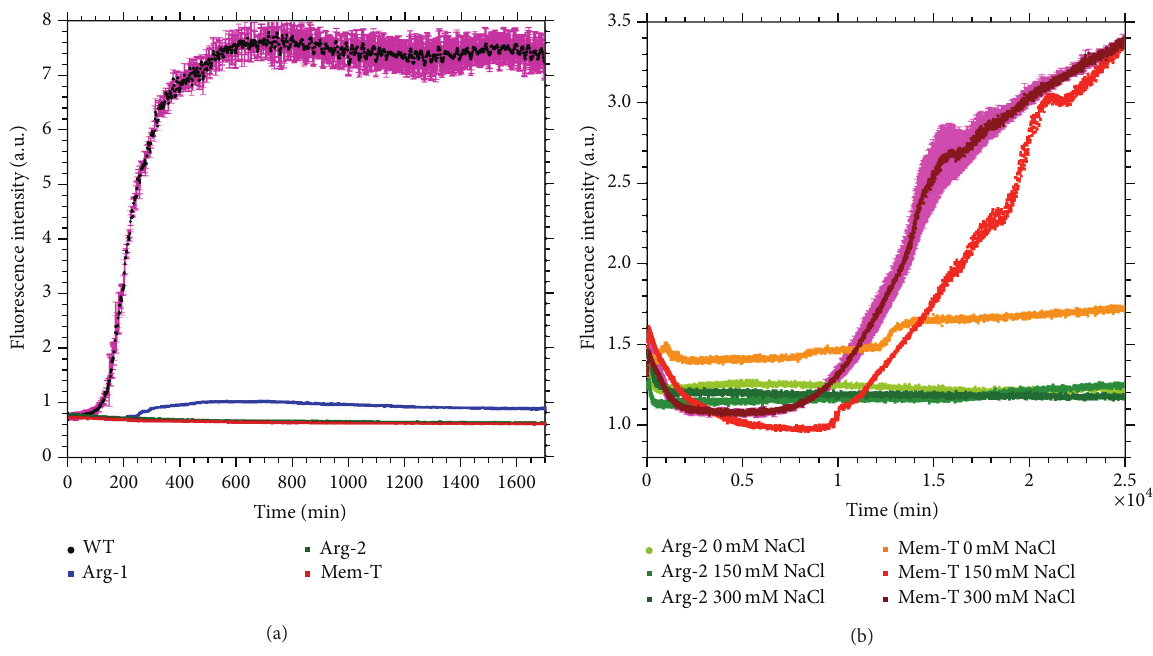
Figure 2: Fibrillization kinetics of WT and charged amylin variants. (a) Reaction profiles for 20 𝜇 M peptide concentrations in the presence of 150 mM NaCl. (b) For the two variants Arg-2 and Mem-T that failed to fibrillize at 20 𝜇 M peptide concentrations, aggregation was also studied at a larger 400 𝜇 M peptide concentrations and the indicated salt concentrations. Representative error bars, calculated as the SEM from triplicate measurements, are shown for WT-amylin in (a) and for Mem-T at 300 mM NaCl in